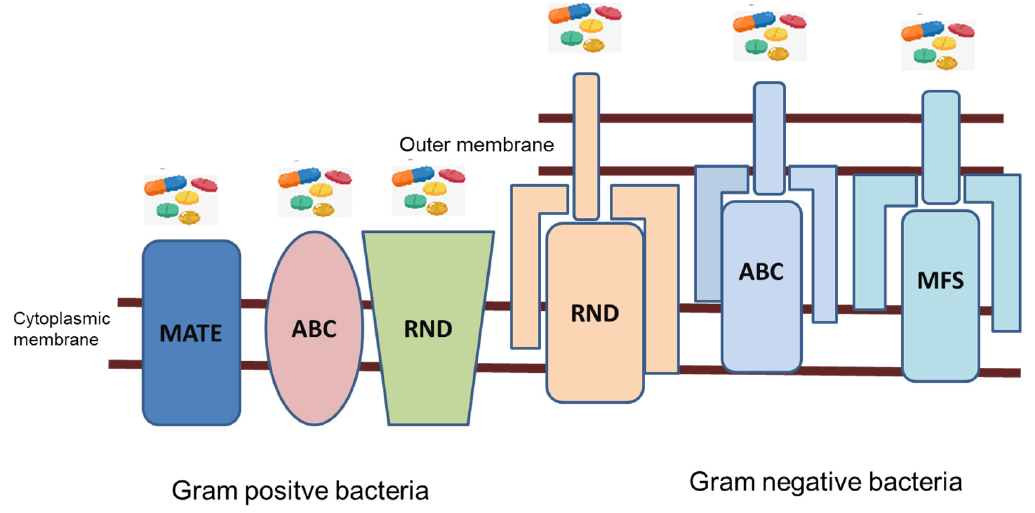
Figure 4. Major efflux pump families (inspired from [34]).